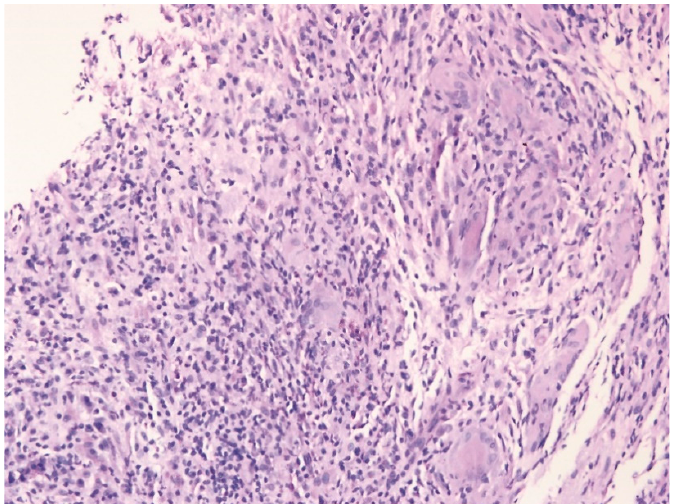
Figure 1. A histopathological examination showed vague non-caseating granulomatous inflammation with epithelioid histiocytes, lymphocytes, scattered neutrophils, and multinucleated giant cells in a patient with idiopathic granulomatous mastitis (H&E × 200).